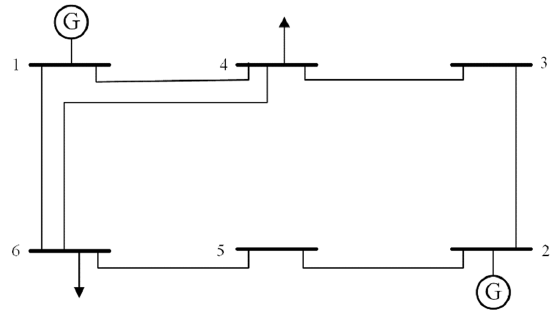
Figure 1. IEEE 6-bus test system single-line diagram.